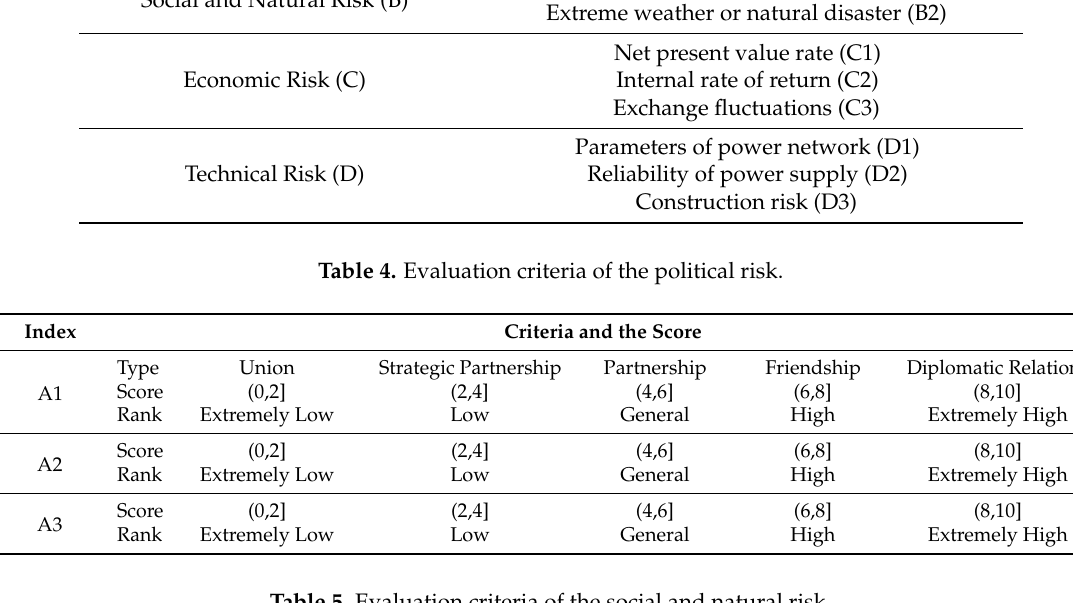
Table 5. Evaluation criteria of the social and natural risk.